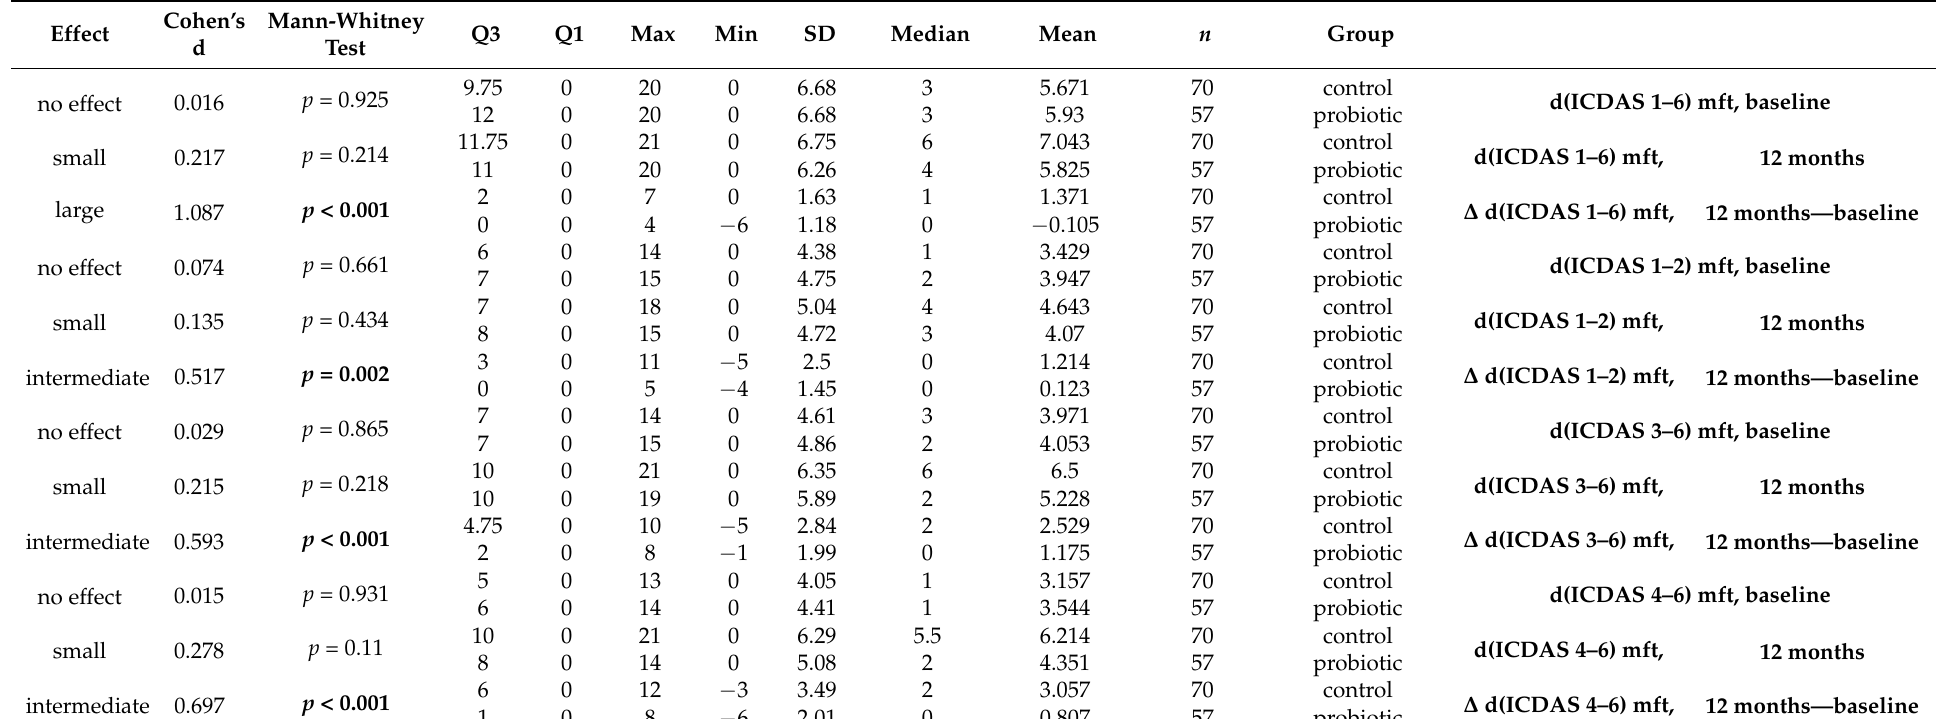
Table 2. Dental caries incidence in the probiotic and control group at baseline and end of the